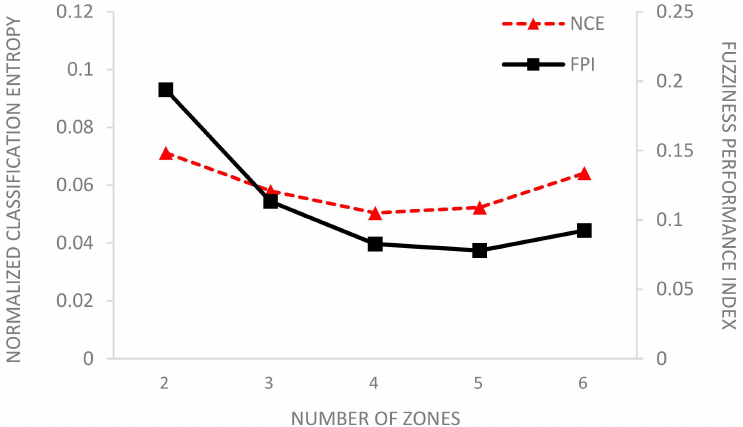
Figure 3. Fuzziness performance index (FPI) and normalized classification entropy (NCE) values as calculated by the Management Zone Analyst during the cluster